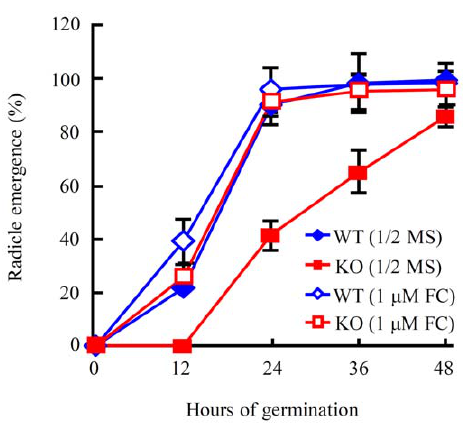
Figure 10. The effects of fusicoccin treatment on the germina- tion of wild type control and hrs1-1 . The seeds of wild type (WT) control and hrs1-1 (KO) were cold stratified for 48 h, followed by germination on 1/2 MS medium or that supplemented with 1 m M fusicoccin (FC). The percentages of radicle emergence (means 6 SD) at the indicated time points were each calculated using the results from triplicate samples. The data shown are typical of three separate germination